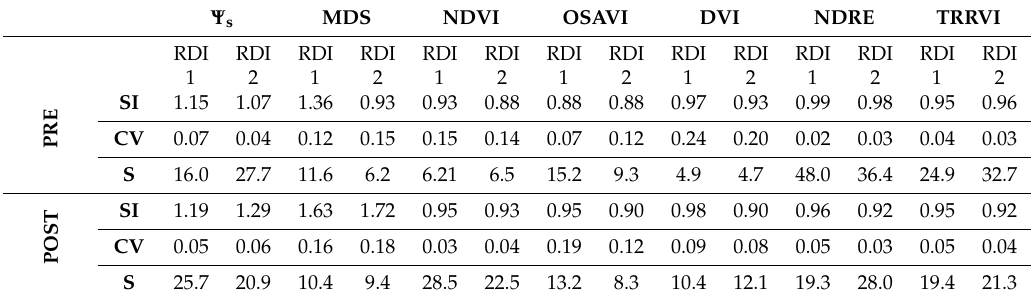
Table 1. Sensitivity analysis of the conventional, continuous plant water status indicators and remote vegetation indices (VI) for RDI-1 and RDI-2 in 2018 to preharvest and postharvest. Ψ s MDS NDVI OSAVI DVI